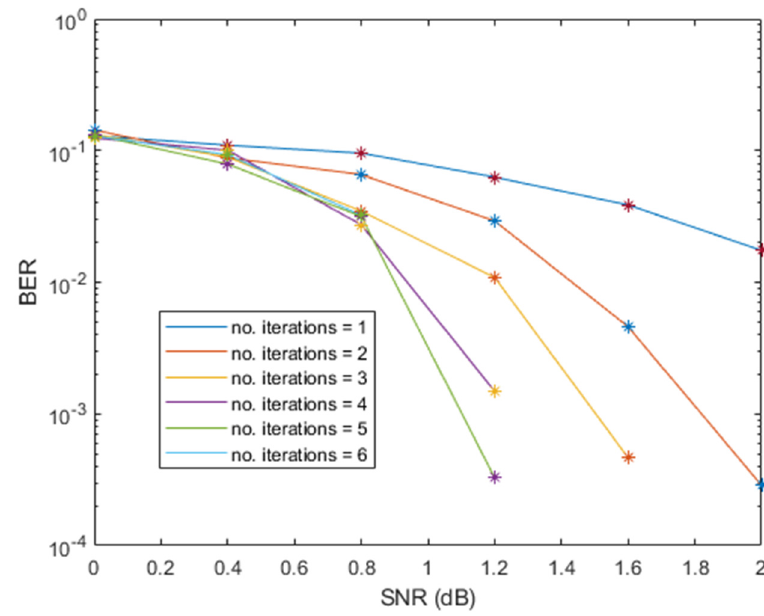
Figure 5. BER performance of Turbo decoding using 𝛥𝑓 (cid:3041) = 3.75 𝑘𝐻𝑧 .